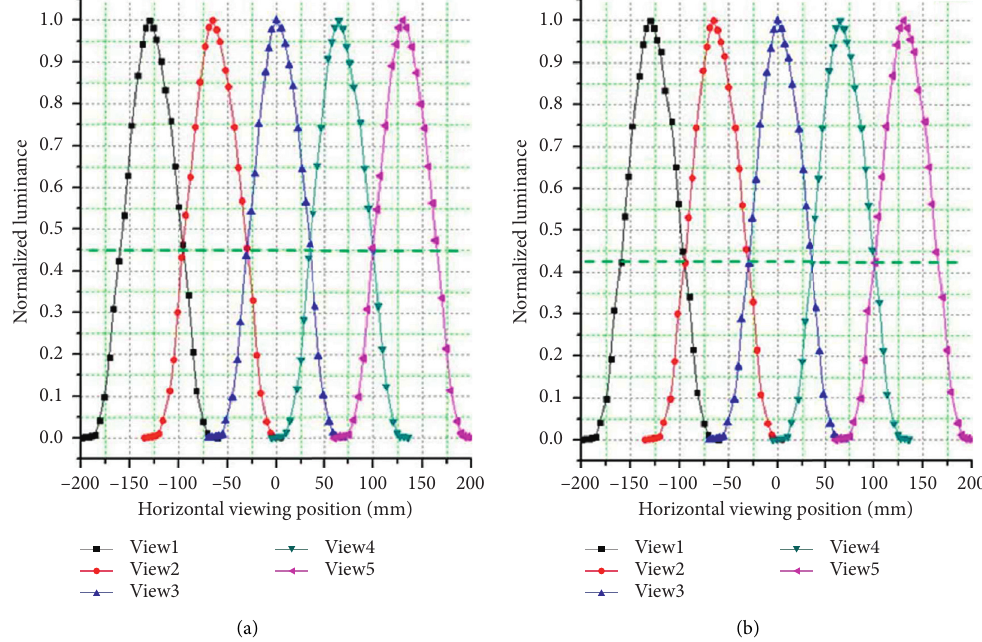
Figure 3: Normalized brightness distribution curves of naked-eye 3D displays based on the parallax barrier at the optimum 3D view distance. (a) Using the proposed parallax barrier; (b) using the conventional vertical parallax